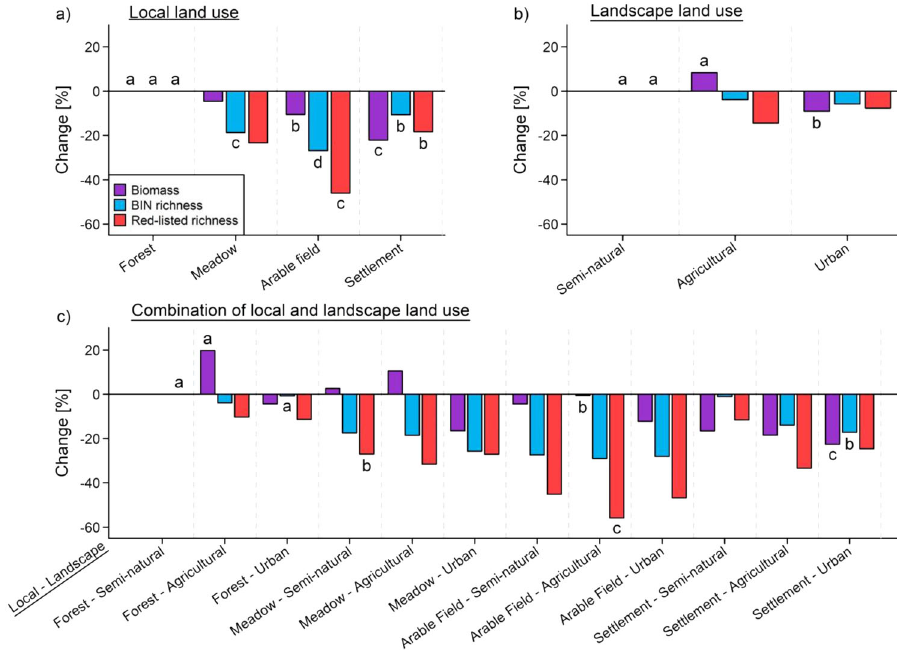
Fig. 3 Partial effects of land use on insect biomass and diversity (total BIN richness and the richness of red-listed species). The results of generalized additive mixed models for insect biomass (8 sampling campaigns, n = 1293), richness of barcode index numbers (BINs), and red-listed species (3 sampling campaigns, n = 510) using land-use categories on local and landscape scales. The displayed values are based on comparisons with ( a ) the local land-use type forest, ( b ) semi-natural landscapes, and ( c ) the combined local land-use type forest in semi-natural landscapes. For model parameters, see Table 1. For additional information see annotated code below. Signi fi cance was tested by multiple post-hoc comparisons using glht (R package multcomp 64 ). Different letters indicate signi fi cant differences ( p < 0.05) between categories. Note that only the fi rst signi fi cant entry for a predictor is shown, subsequent entries between land-use categories, even if signi fi cant, were omitted for clarity.